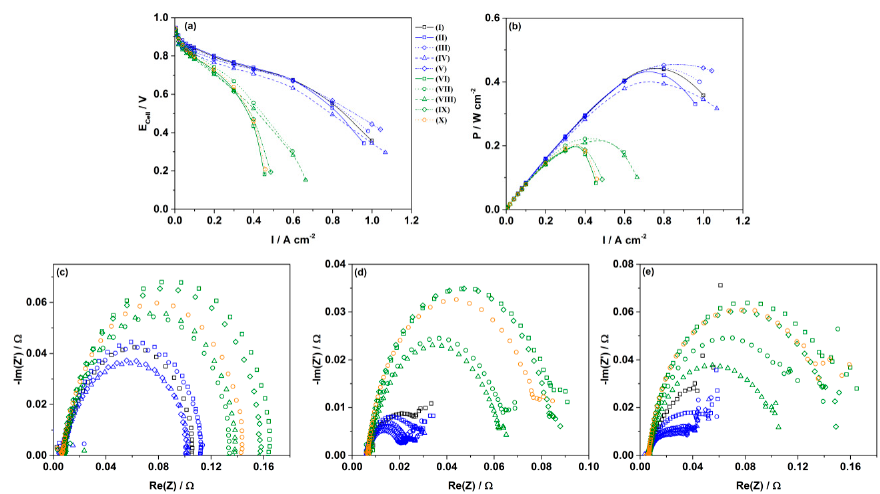
Figure 5. ( a ) Polarisation curves; ( b ) Power density curves and ( c – e ) EIS conducted at 0.48 A, 0.65 V, and 0.5 V respectively on electrodes of (I) Pt/C (TKK); (II) Pt NWs/C (III) Pt NWs/C (150 °C); (IV) Pt NWs/C (250 °C); (V) PtNWs/C (350 °C); (VI) PtNi NWs/C; (VII) PtNI NWs/C (150 °C); (VIII) PtNi NWs/C (250 °C); (IX) PtNi NWs/C (350 °C); and (X) PtNi NWs/C (150 °C, 72 h).